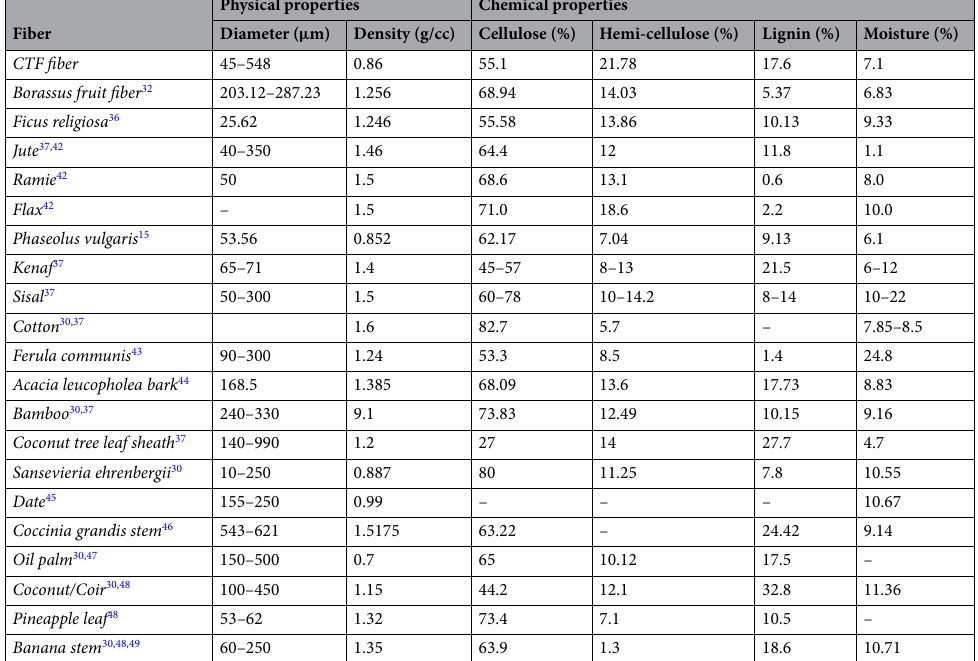
Table 1. Comparison table of physical and chemical properties of CTF fibers with other natural fibers.